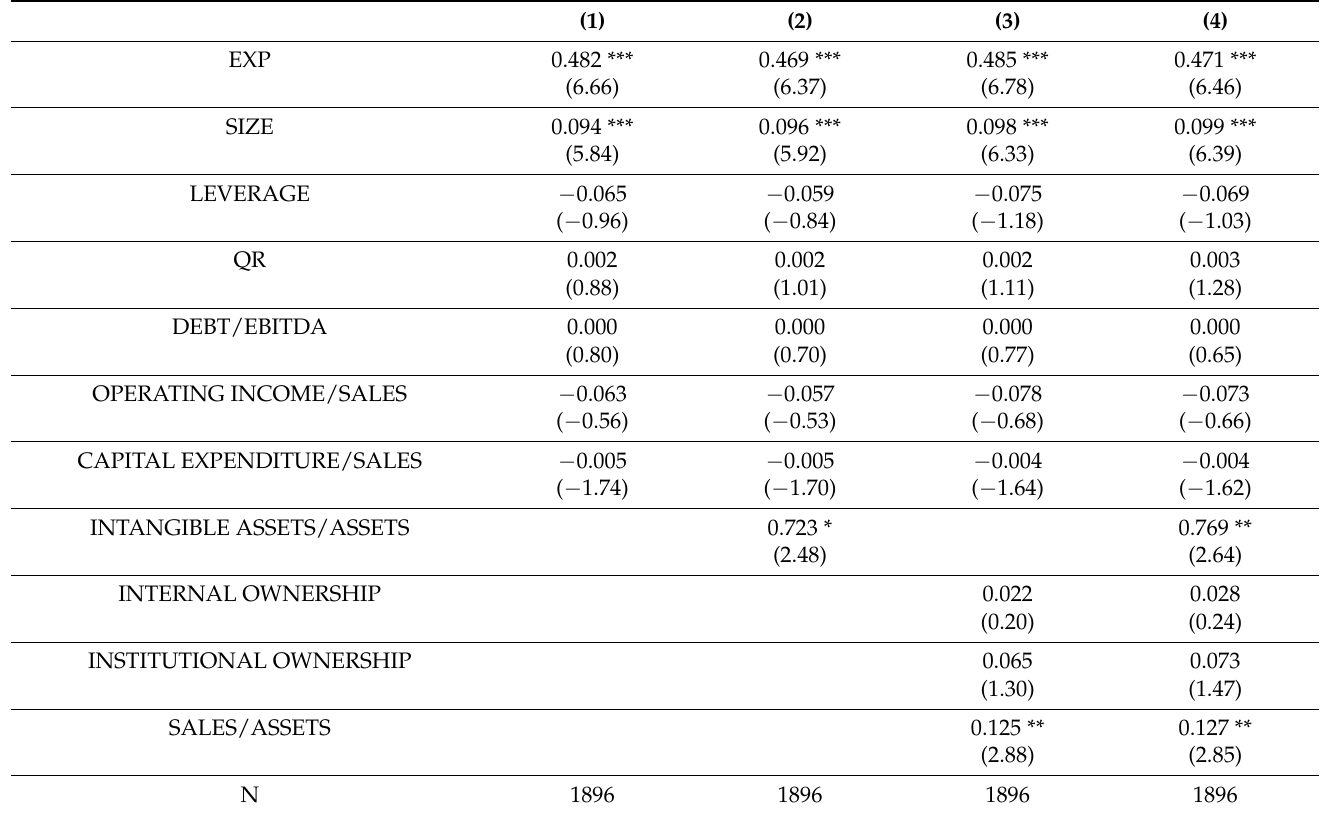
Table 4. Average marginal